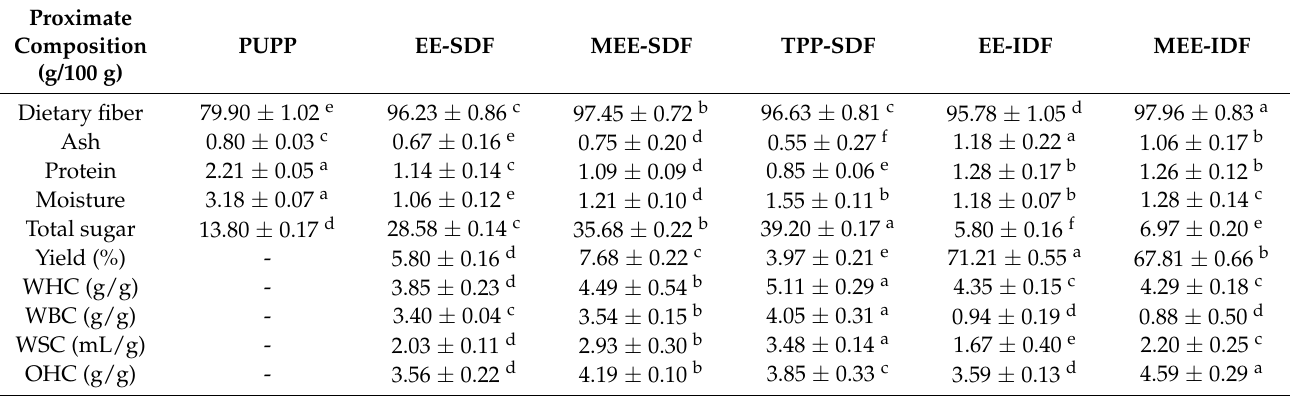
Table 1. Dietary fiber components by different extraction